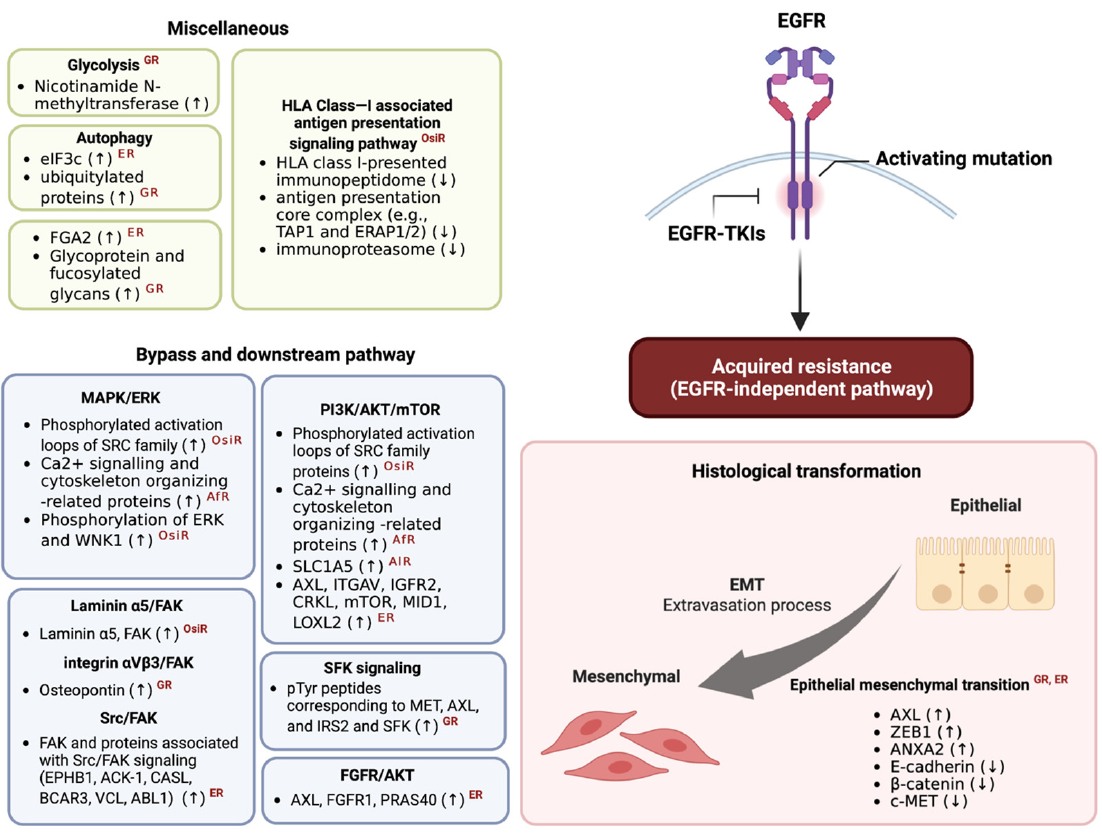
Figure 1. Summary of dysregulated proteins in proteomics studies of acquired resistance of EGFR- TKI through EGFR-independent pathway in NSCLC. Up arrows indicate upregulated proteins. Down arrows indicate downregulated proteins.